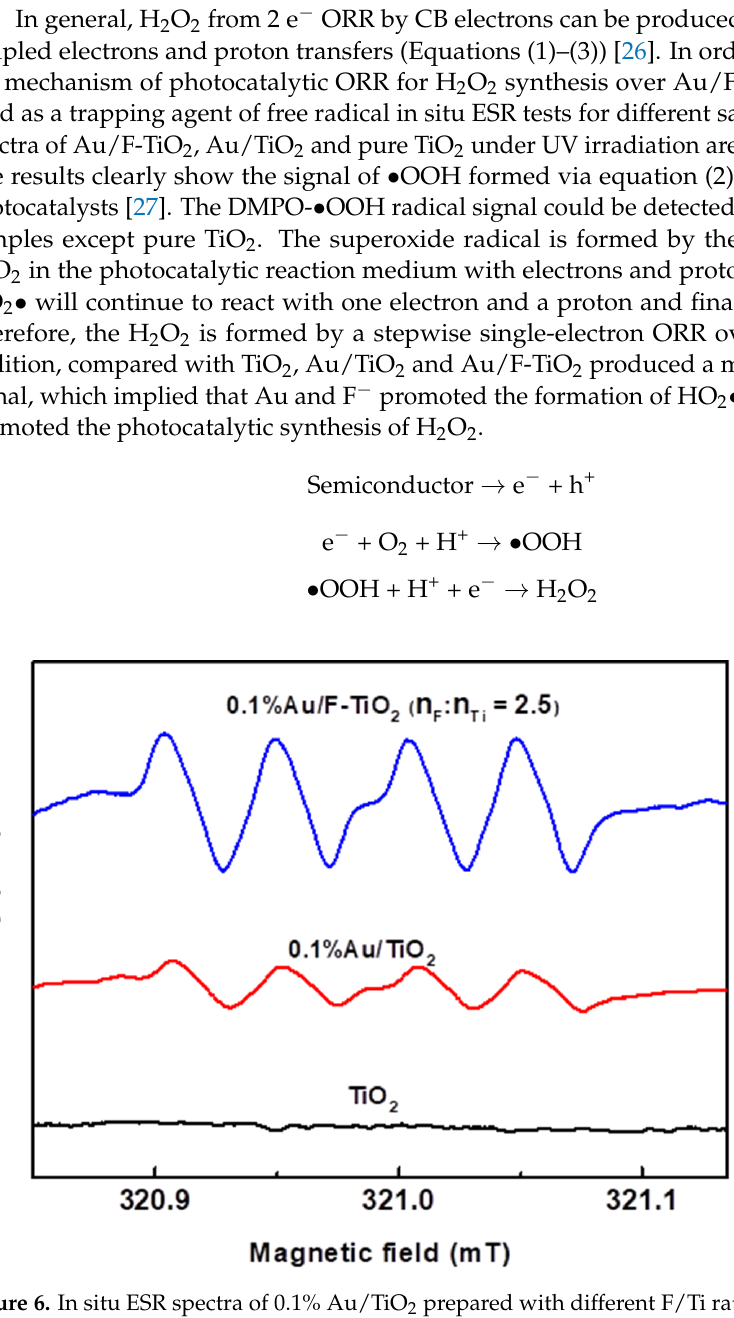
Figure 6. In situ ESR spectra of 0.1% Au/TiO 2 prepared with different F/Ti ratios and pure TiO 2